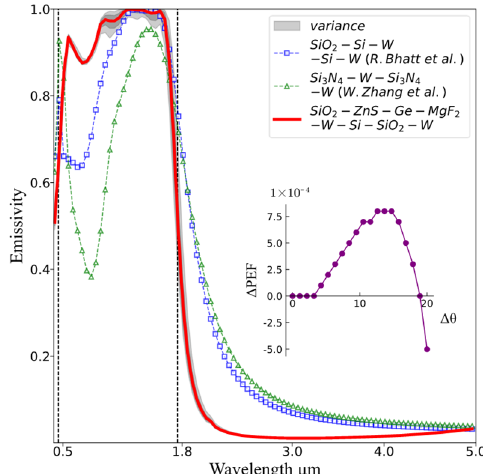
Figure 7. Analysis of the emission spectrum regarding the optimal structure obtained via BOnSA in comparison with other works.